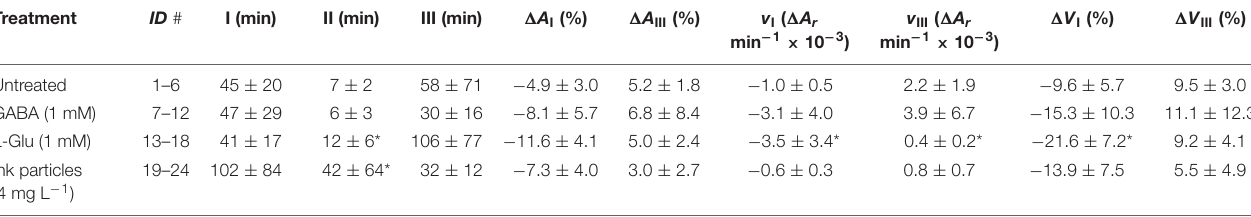
TABLE 3 | Halichondria panicea . Spontaneous (i.e. untreated conditions) and induced (by exposure to the neurotransmitters GABA, L-Glu or ink particles) contraction-expansion events of sponge explants ( n = 6, ID #1–24), expressed by changes in the relative projected area ( A r ) and relative volume ( V r ; Eq. 3).